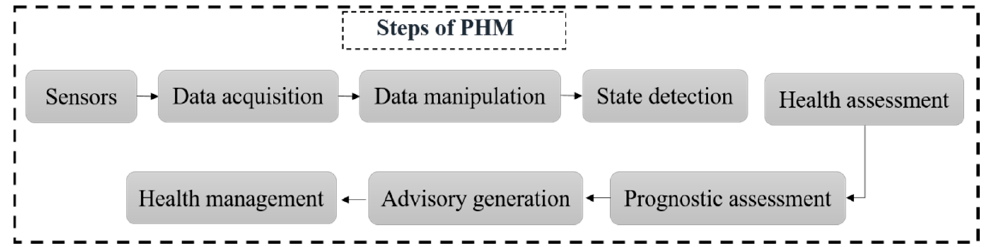
Figure 1. Steps involved in the prognostic health management (PHM) process.